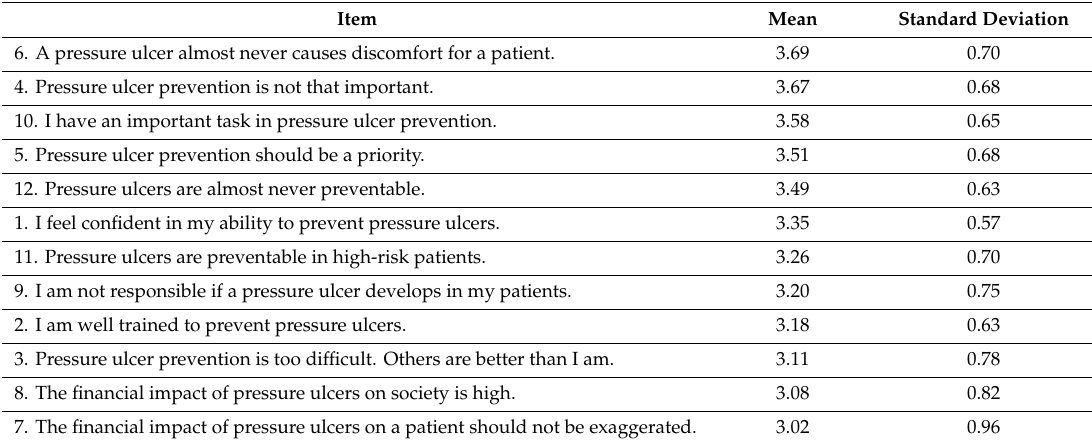
Table 7. Descriptive values of the items of the questionnaire of attitudes towards the prevention of LPP (Spanish version).